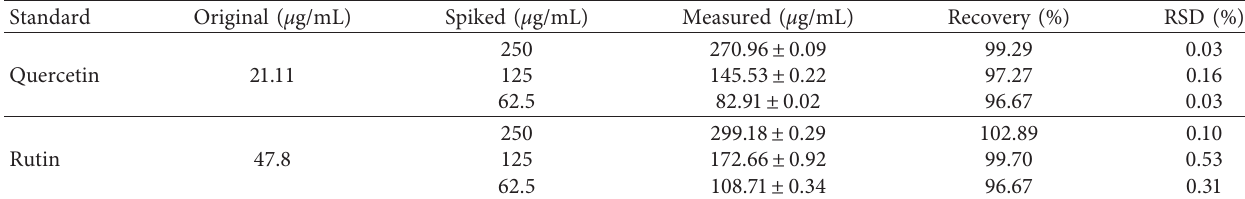
Table 7: Recovery data of spiked standard to the M. domestica extract.